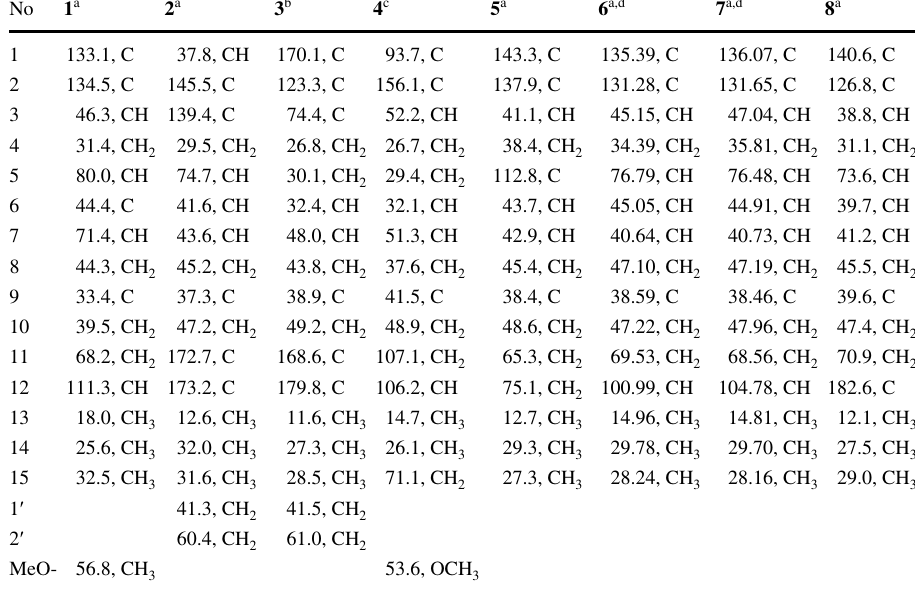
Table 4 13 C NMR spectroscopic data of compounds 1 – 8 (150 MHz, δ in